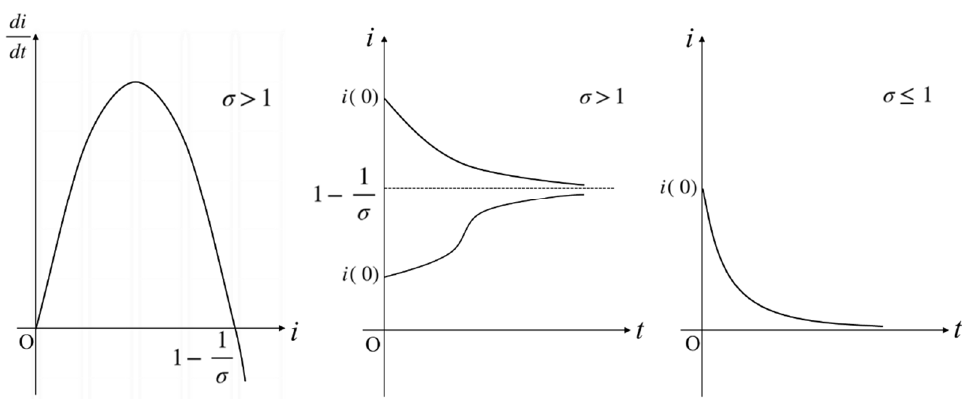
Figure 2. Motion trajectory of i ( t )